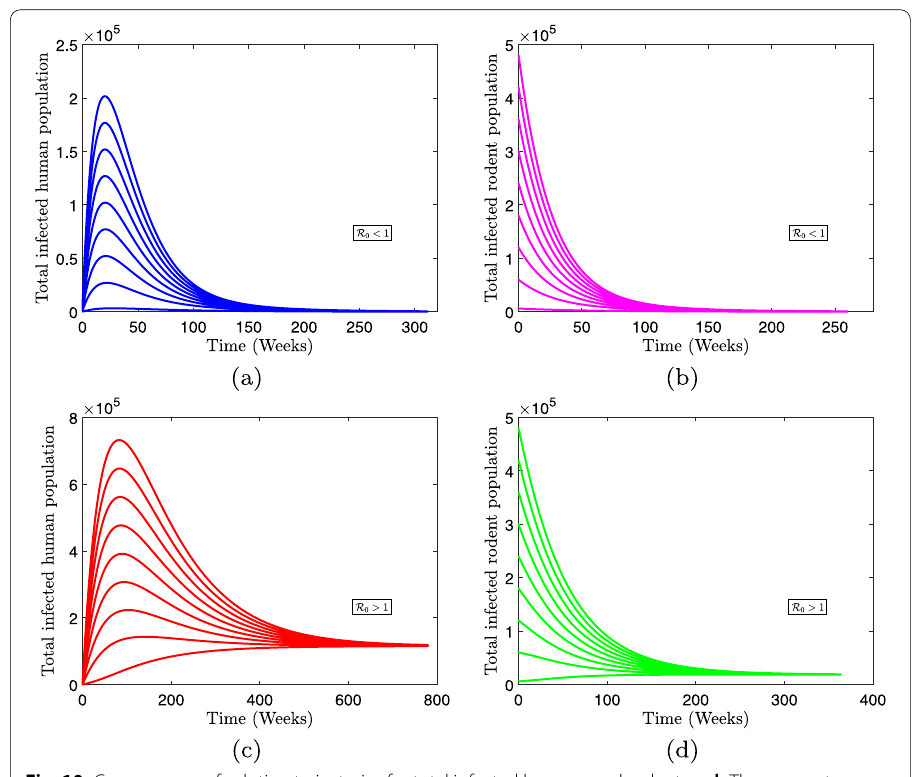
Fig. 10 Convergence of solution trajectories for total infected humans and rodents. a , b The parameter values as given in Table 2 except for β h = 0.063 , and µ r = 0.038 such that R 0 = 0.67 < 1 . c , d The parameter values as given in Table 2 except for β r = 0.051 , such that R 0 = 2.65 >